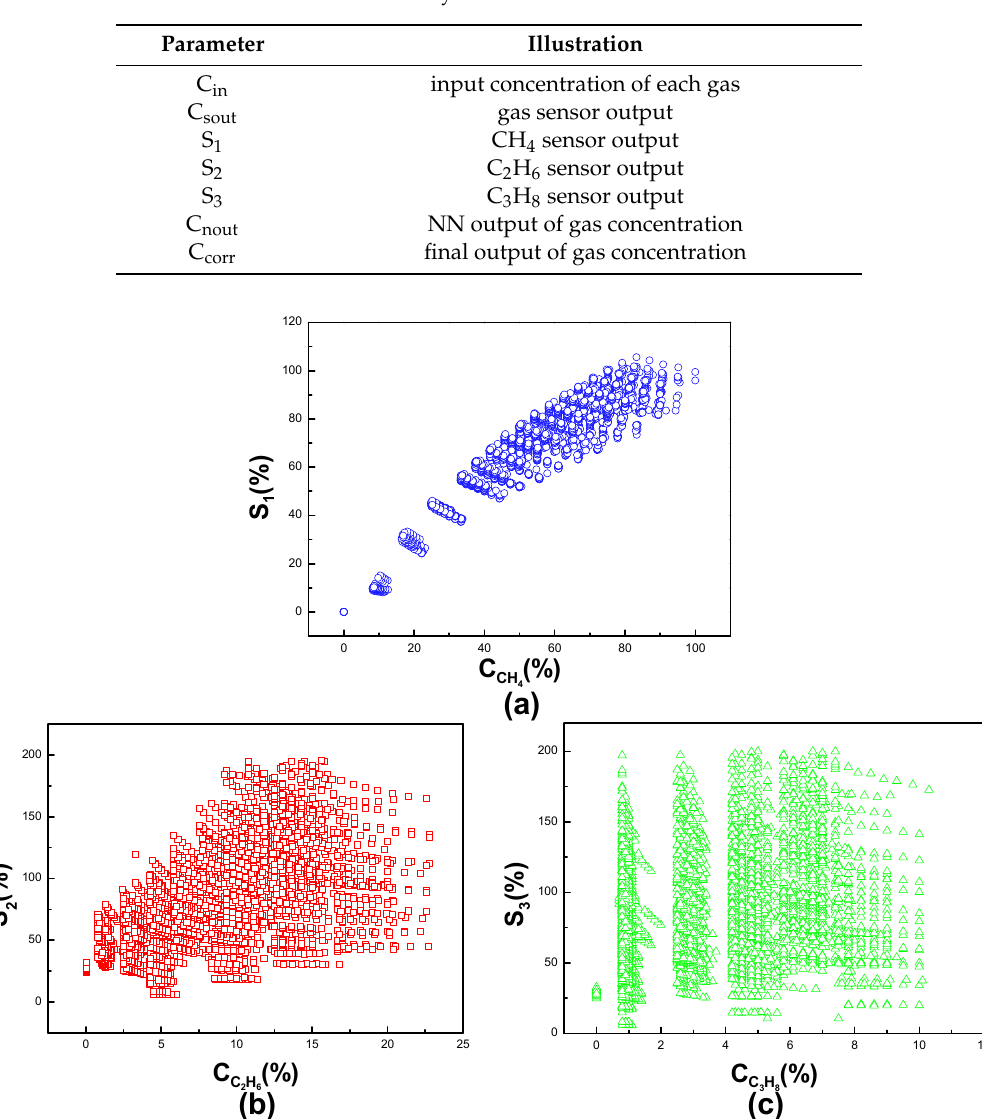
Figure 6. The output of the three gases obtained by the linear system. ( a )–( c ) shows the concentrations of methane, ethane and propane obtained in the linear system, respectively.